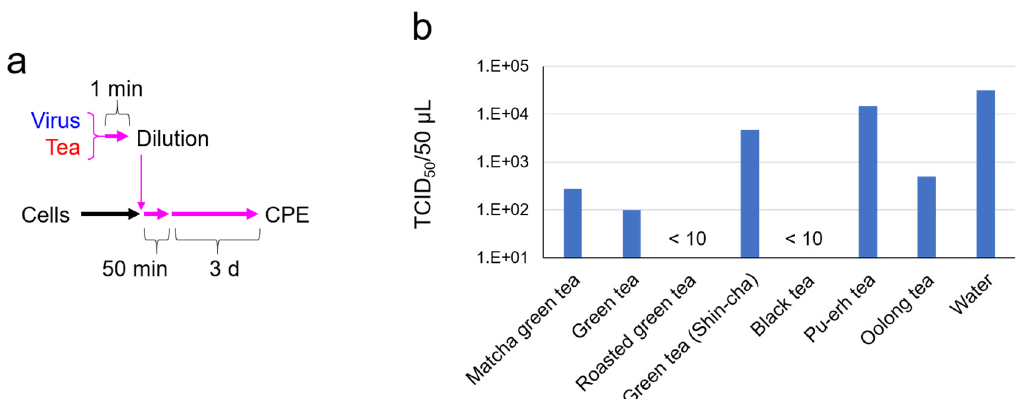
Figure A1. Effects of various tea beverages on infectivity of the novel coronavirus. Powdered matcha green tea, as well as leaves of green tea, roasted green tea (Hojicha), green tea (Shin-Cha, i.e., first picking of a season), black tea, Pu-erh tea, and oolong tea were purchased at a supermarket in Kyoto, and brewed in hot water according to each recipe indicated on the package. After filtrated through a 0.22 µ m filter, 500 µ L of each sample was mixed with 20 µ L of SARS-CoV-2 suspension (5 × 10 5 TCID 50 /50 µ L) and incubated at room temperature for 1 min ( n = 1). Immediately, each mixture was serially diluted 10-fold into MS, and 50 µ L of the samples were added to VeroE6/TMPRSS2 cells that had been cultured in 96-well-plates overnight ( n = 4 wells per each dilution). Plates were incubated for 50 min with gentle shaking every 10 min. Fifty µ L of MS was added to the cells, which were subsequently cultured under standard conditions for 3 days. Cells were stained with Crystal Violet, and TCID 50 values were calculated by Reed–Muench method as described elsewhere ( n = 4 wells per each dilution). ( a ) Experimental protocol is shown. Pink arrows represent the presence of tea and virus. ( b ) TCID 50 /50 µL values are shown.